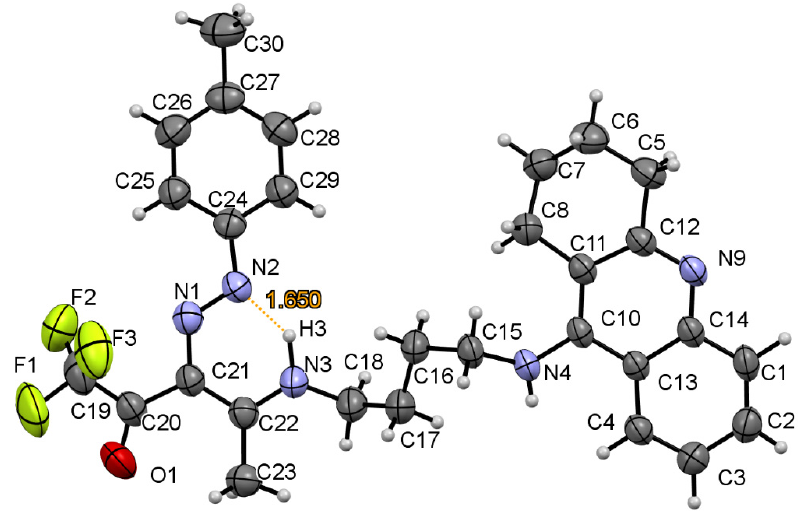
Figure 1. The ORTEP view of conjugate 8a .